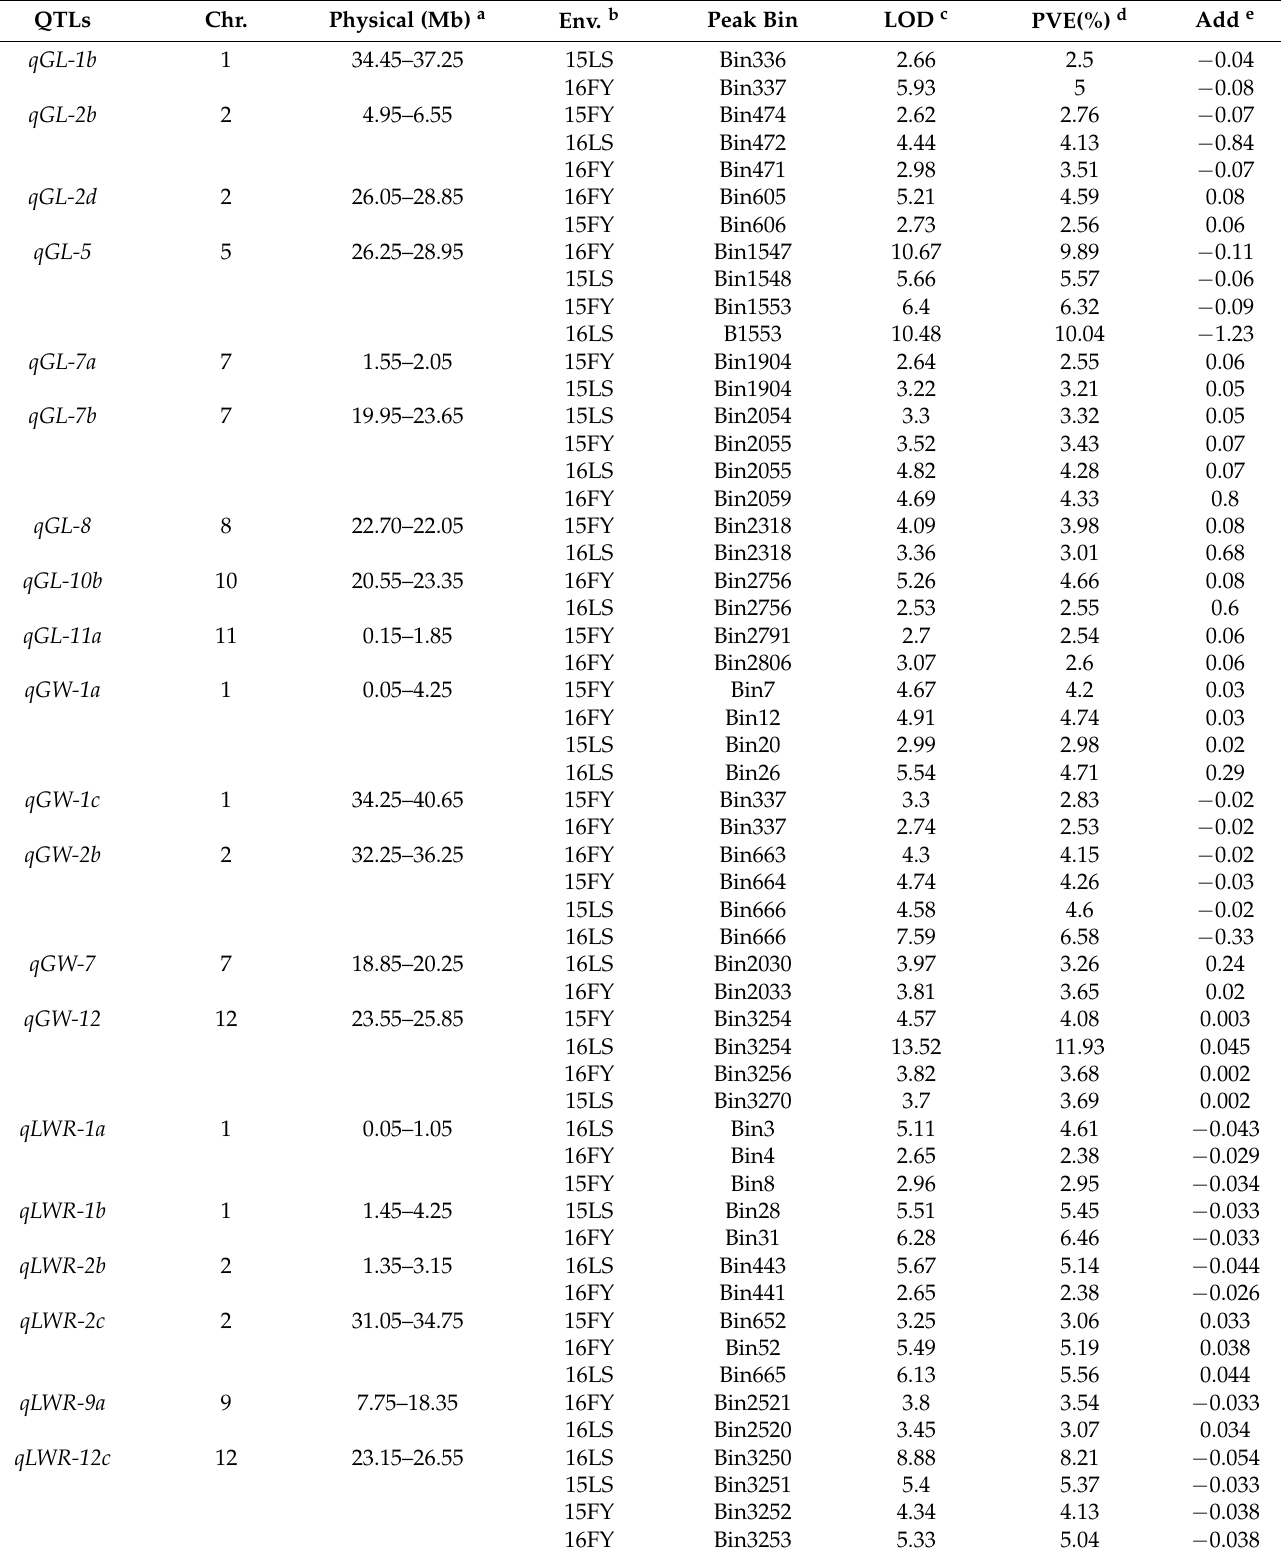
Table 1. Twenty QTLs for grain shape identified in the RISL population across two or more environments.